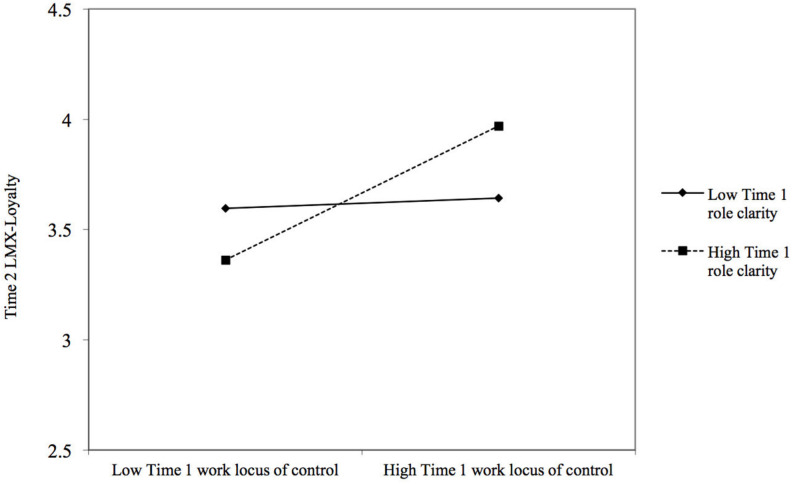
Interaction between Time 1 work locus of control and Time 1 role clarity predicting Time 2 LMX-Loyalty, controlling for Time 1 LMX-Loyalty. Relationships are shown at 1 SD above and below the mean of Time 1 role clarity.